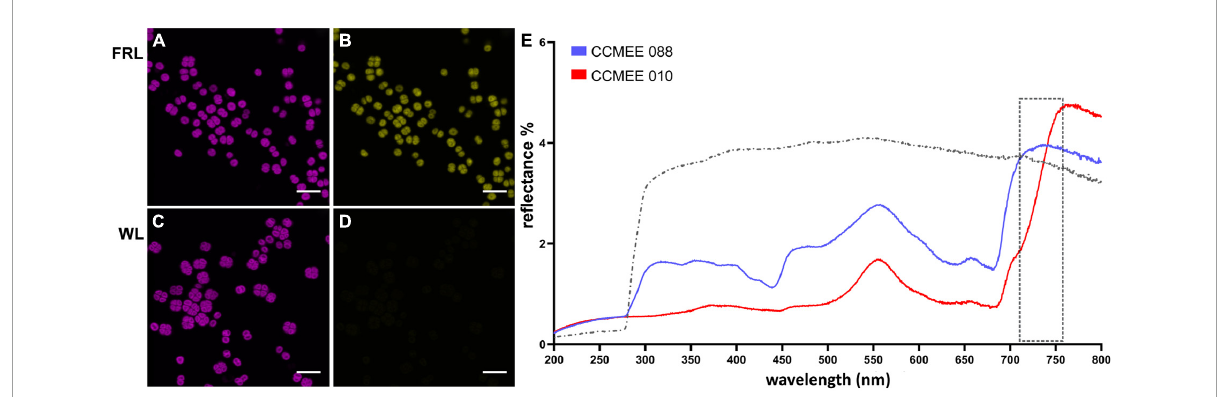
FIGURE3 Spectral characteristics of far-red light photoacclimation. CSLM images of Chroococcidiopsis sp. CCMEE 010 grown for 14 days under FRL (A) or WL (C) in the 650–680 nm emission range. Red-shifted Chl f presence in FRL-acclimated cells in the 720–750 nm emission range (B) and absence in WL cells (D) . Scale bars 20 µ m. Reflectance spectra (E) of the FaRLiP positive Chroococcidiopsis sp. CCMEE 010 (red line) and FaRLiP negative Chroococcidiopsis sp. CCMEE 088 (blue line) dried on polycarbonate filters (gray line).